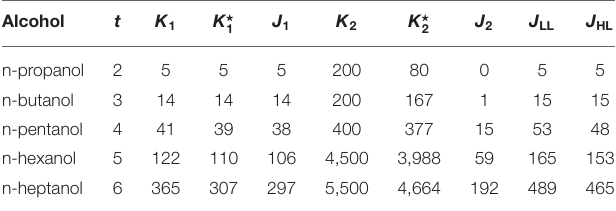
TABLE 1 | Number of conformers obtained for the n-alcohol series that illustrate the efficiency of the algorithm. Alcohol